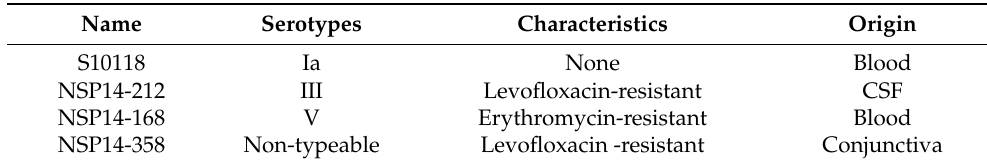
Table 1. Group B Streptococcus strains used in this